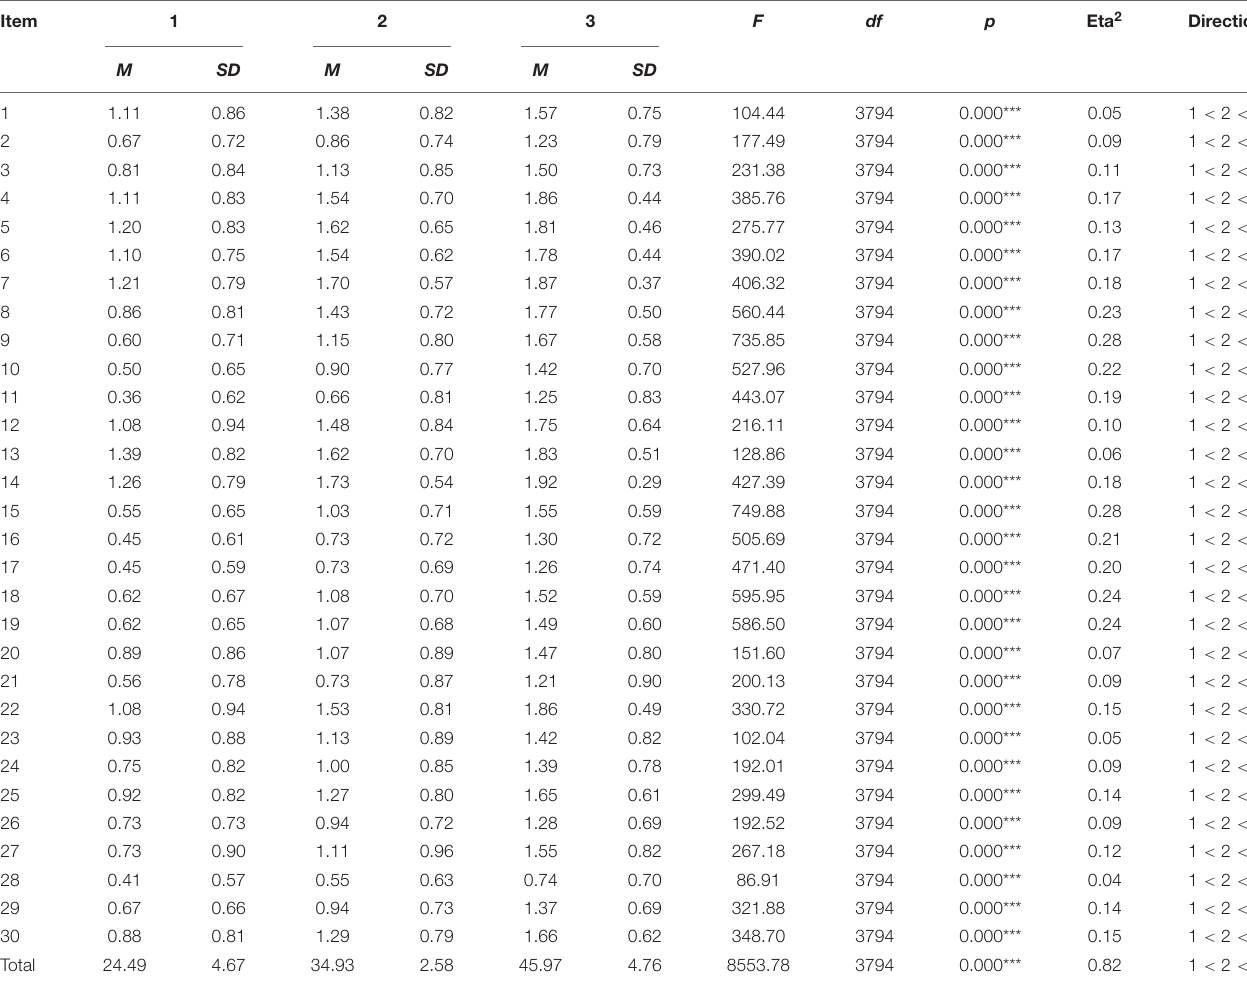
TABLE 6 | ANOVA Test comparing performance